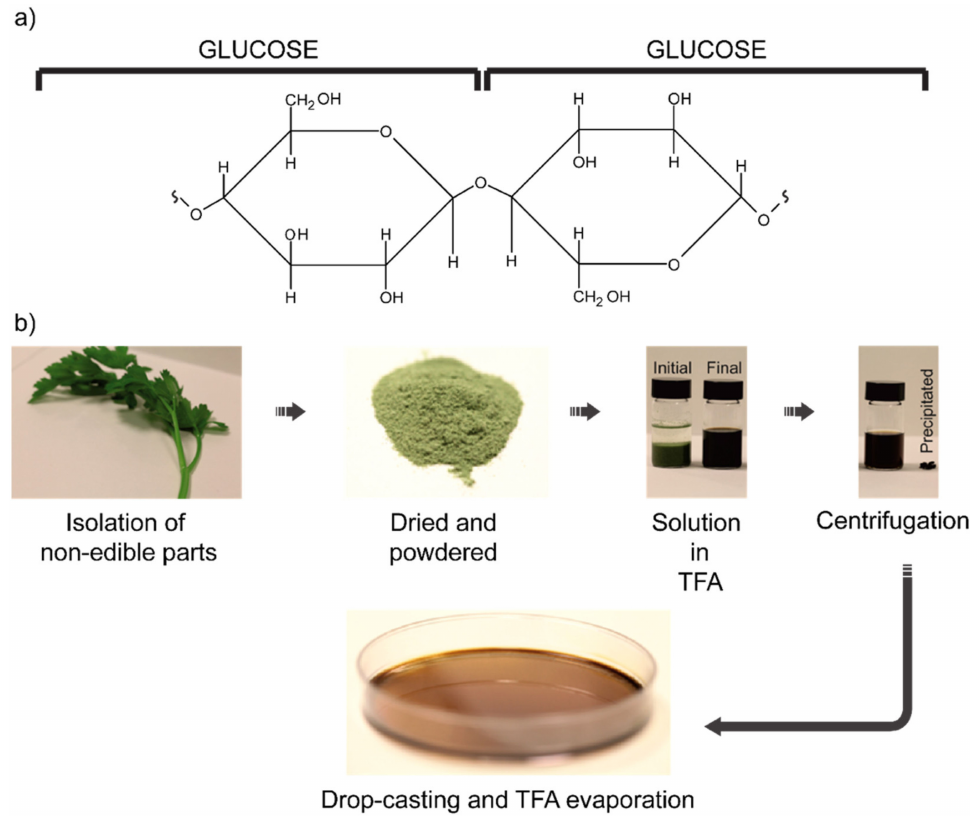
Figure 6. Cellulose structure and preparation : ( a ) Cellulose polymeric chain formed via glycosidic bond between multiple D-glucose subunits. ( b ) Cellulose purification scheme for the achievement of bioplastics from non-edible agro-wastes. Powdered wastes from vegetables are dissolved in TFA, centrifuged and casted to let the solvent evaporate and obtain the film. Reproduced with permission from reference [93], Copyright 2014, American Chemical